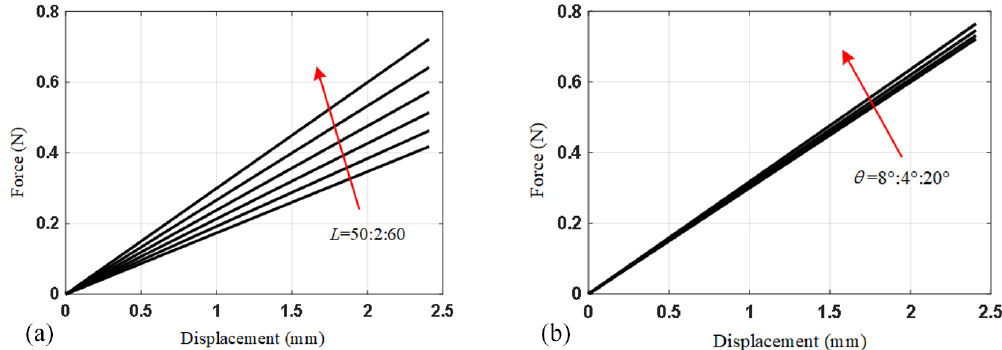
Figure 7. Variation tendencies of segment OA of the in-plane lateral force–displacement curve of the conventional bistable mechanism at the unstable equilibrium point. (a) The beam length L is varied; (b) the inclined angle β is varied.